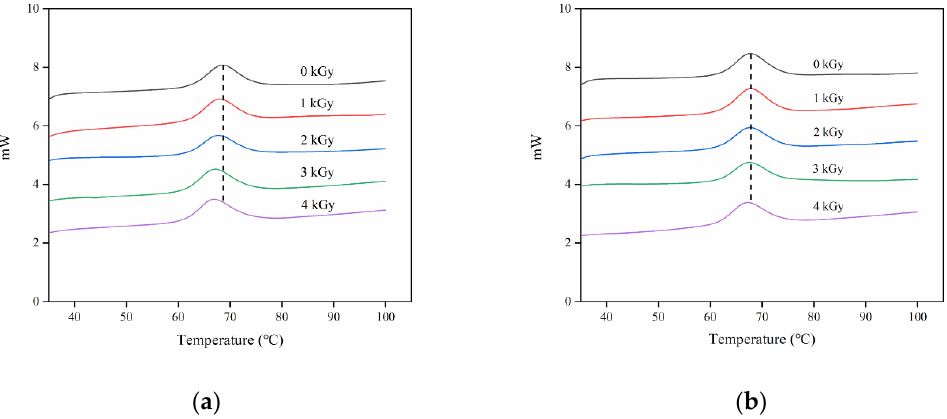
Figure 6. Differential scanning calorimeter (DSC) thermograms of the starches isolated from rice grains treated with various irradiation doses. ( a ) LM rice, ( b ) HM rice.